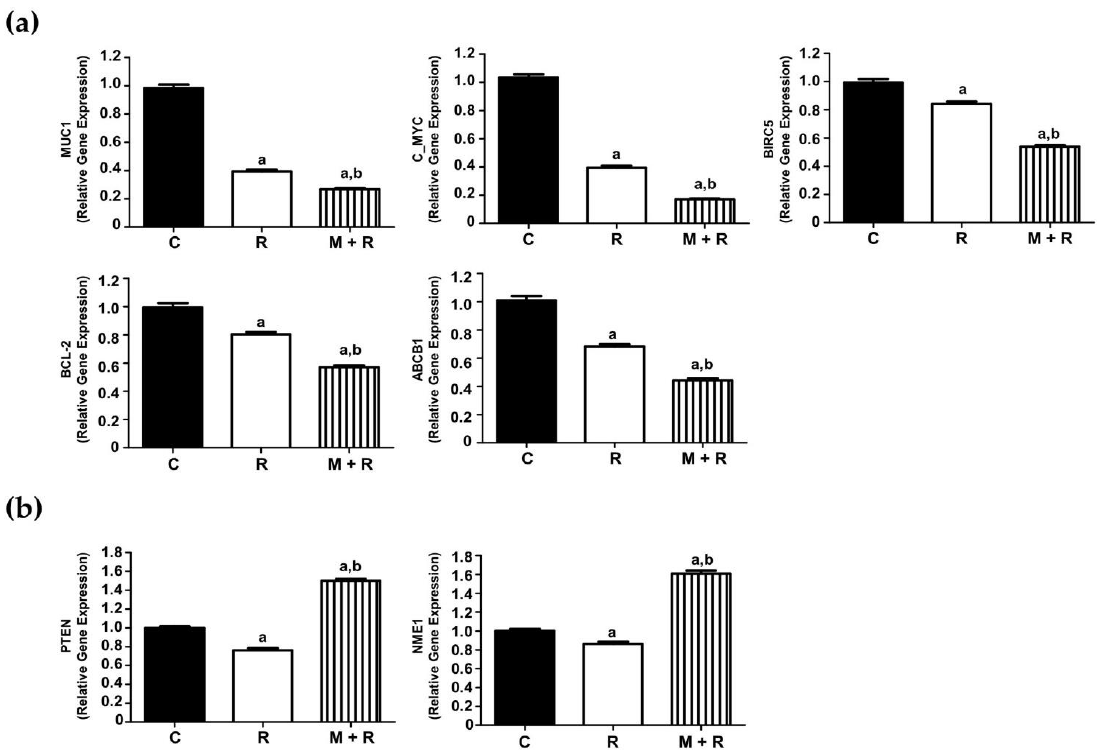
Figure 2. Effects of melatonin and radiation treatments on breast cancer-related gene expression in MCF-7 cells. ( a ) RT-PCR analysis of selected genes (MUC-1, c-MYC, BIRC5, BCL-2 and ABCB1) where the pre-treatment with melatonin (1 nM) further enhanced the inhibitory effect of radiation (8 Gy); ( b ) RT-PCR analysis of selected genes (PTEN, NME1), where melatonin pre-treatment reverted the inhibitory effect of radiation. All data are expressed as fold-changes relative to non-radiated (control) cells (mean ± S.E.M.). a, p ≤ 0.001 vs. C; b, p ≤ 0.001 vs. R. C: Control; R: Radiated cells (8 Gy); M + R: Melatonin pre-treated and radiated cells.